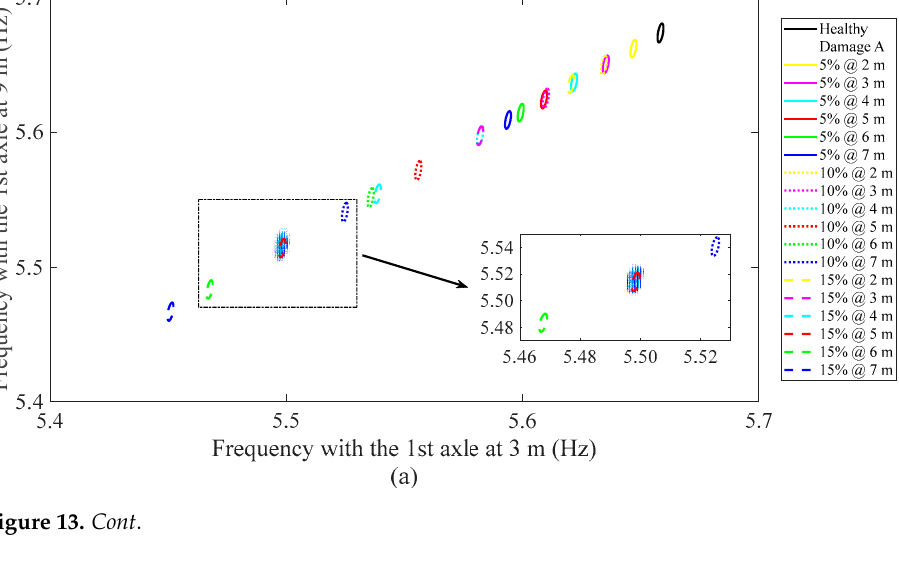
and 𝐹 in Figure (cid:2871) (cid:2877)